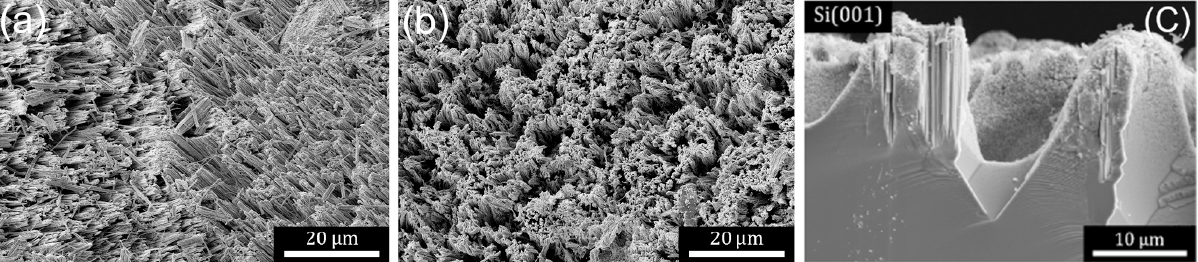
Figure 3. Secondary electron scanning electron microscope (SEM) images of etched Si particles using Ag-catalyzed HL- MACE. ( a ) Single crystal and ( b ) metallurgical-grade Si powders both etch to reveal primarily parallel etch track pores as a result of etching with HL-MACE. ( c ) Etching of a textured Si(001)-oriented wafer shows that the Ag nanoparticles etch primarily along {001} directions irrespective of the incline of the external surface of the substrate. Copyright © 2021 Kolasinski, Unger, Ernst and Aindow. Reproduced under Creative Commons Attribution License (CC BY) from Ref. [72].